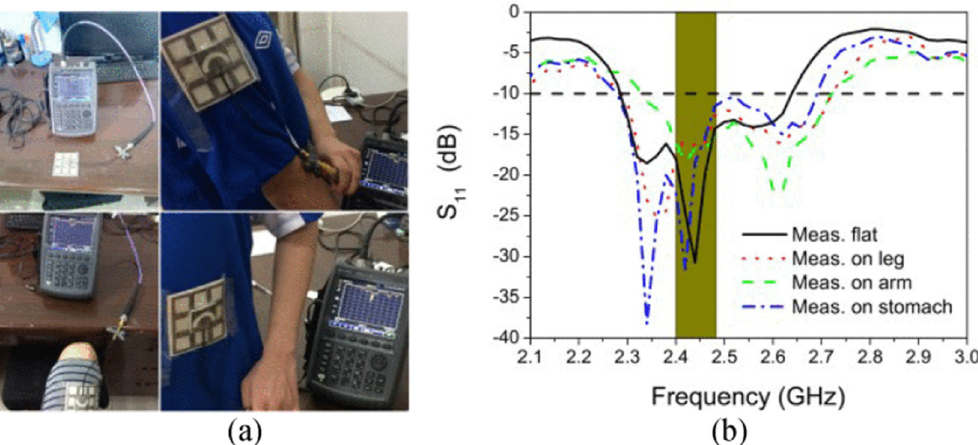
Figure 20. Measured S (cid:2869)(cid:2869) of the proposed antenna placed on human tissue. ( a ) Measurement setup and ( b ) S (cid:2869)(cid:2869) curves